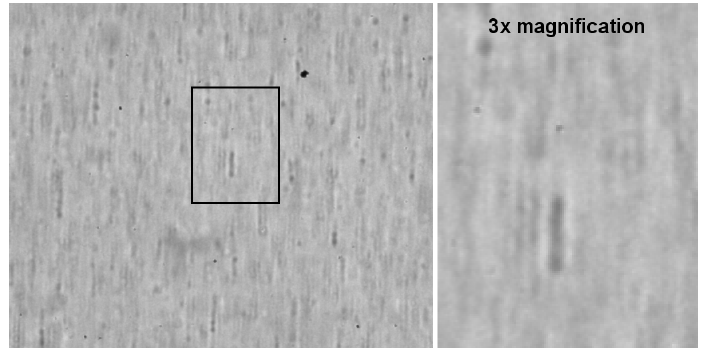
Figure 4. Magnetic particle behavior in the switchable magnetic field. ( a ) Bright-field transmission microscopy of magnetic nanoparticles dispersed in glycerin (0.5 mg/mL) in a freshly prepared sample; ( b ) after 30 min exposure to the permanent magnetic field with the solenoid switched off; and ( c ) shortly after with the solenoid switched on (30 V). The dominant direction of the magnetic field is indicated by the symbols in the upper left corner of the images ( ↑ —transverse,  —longitudinal). The indicated coordinate system ( x , y ) is identical to Figure 2a. As illustrated by the magnified views (red rectangles), the particles in ( b ) have formed long chains that are aligned parallel to the image plane; when the solenoid is switched on in ( c ), these chains rotate and align perpendicular to the image plane. This rotation effect is reversible across many on/off cycles of the solenoid (see Scheme 1 and Video S1) (color